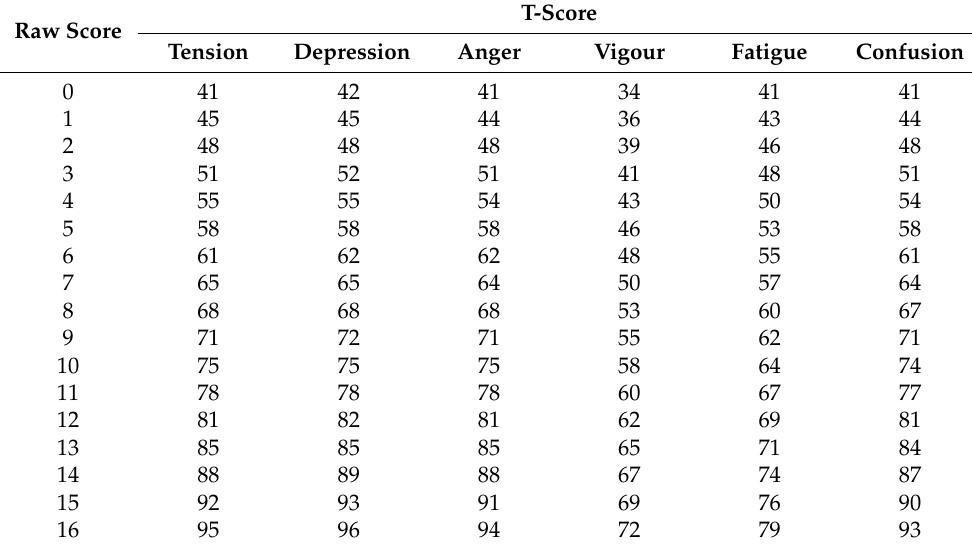
Table 7. MASMS normative scores for the male non-athlete sample ( n = 1318).